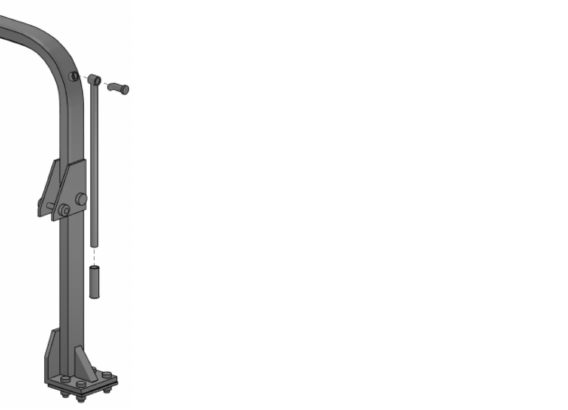
Figure 3. The rod (right) and the gas spring (left) prototyped and mounted on the enhanced FROPS to improve the handling of the upper inverted U-shaped folding steel